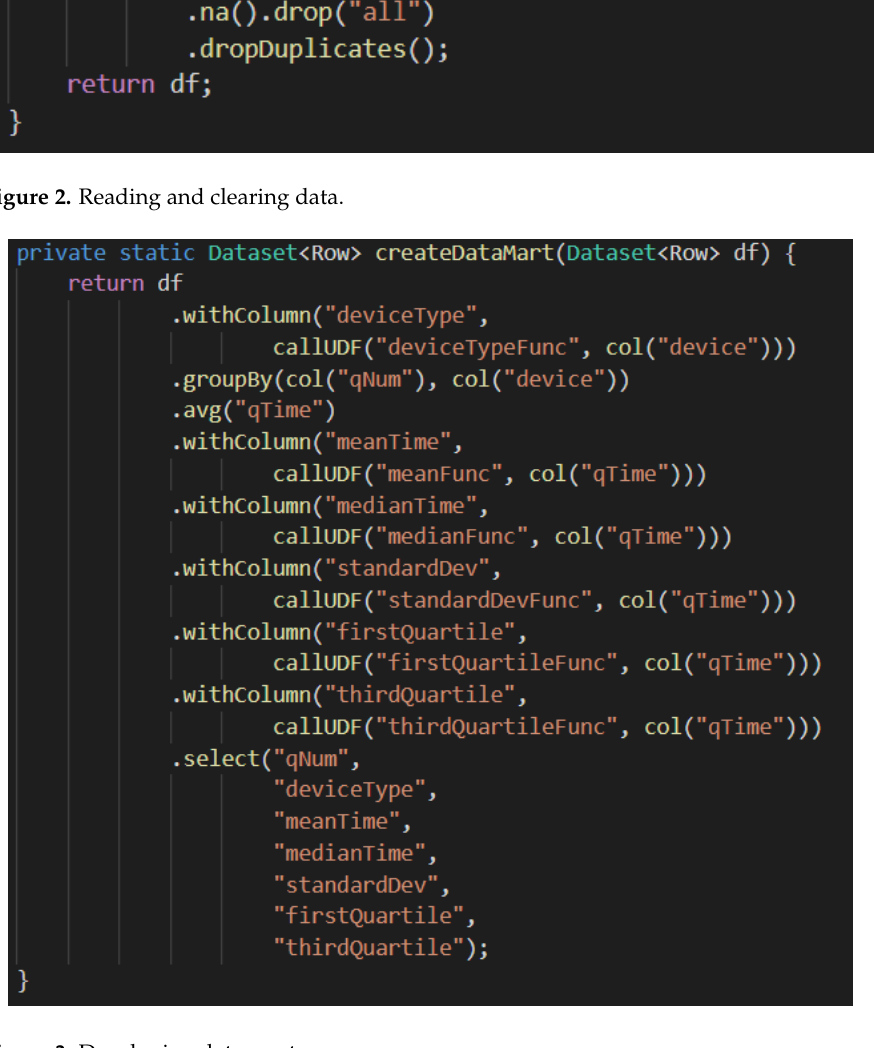
Figure 3. Developing data